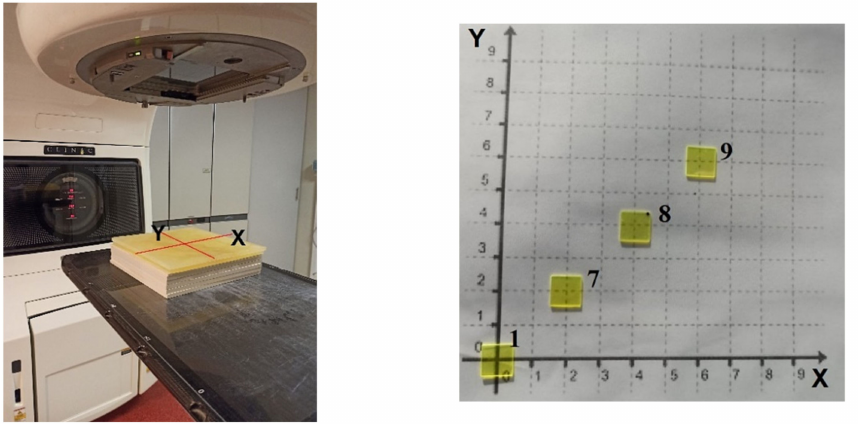
Figure 1. The position of the samples on the table of Clinac 2300CD Silhouette (Varian Medical Systems, Palo Alto, CA, USA) accelerator relative to the center of target ( left side ) and the position of the YAG:Ce detectors on the experimental x-y plane ( right side ). The positions of the detectors are also identified by numbers in the x-y plane of the right